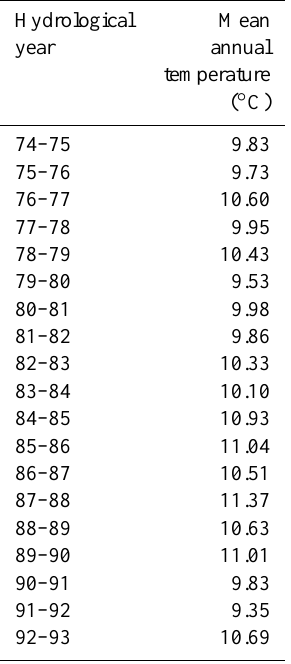
Table 7. Mean annual temperatures at the Glafkos catchment (mean elevation: 1060ma.m.s.l.) for the period 1 October 1974 to 30 September